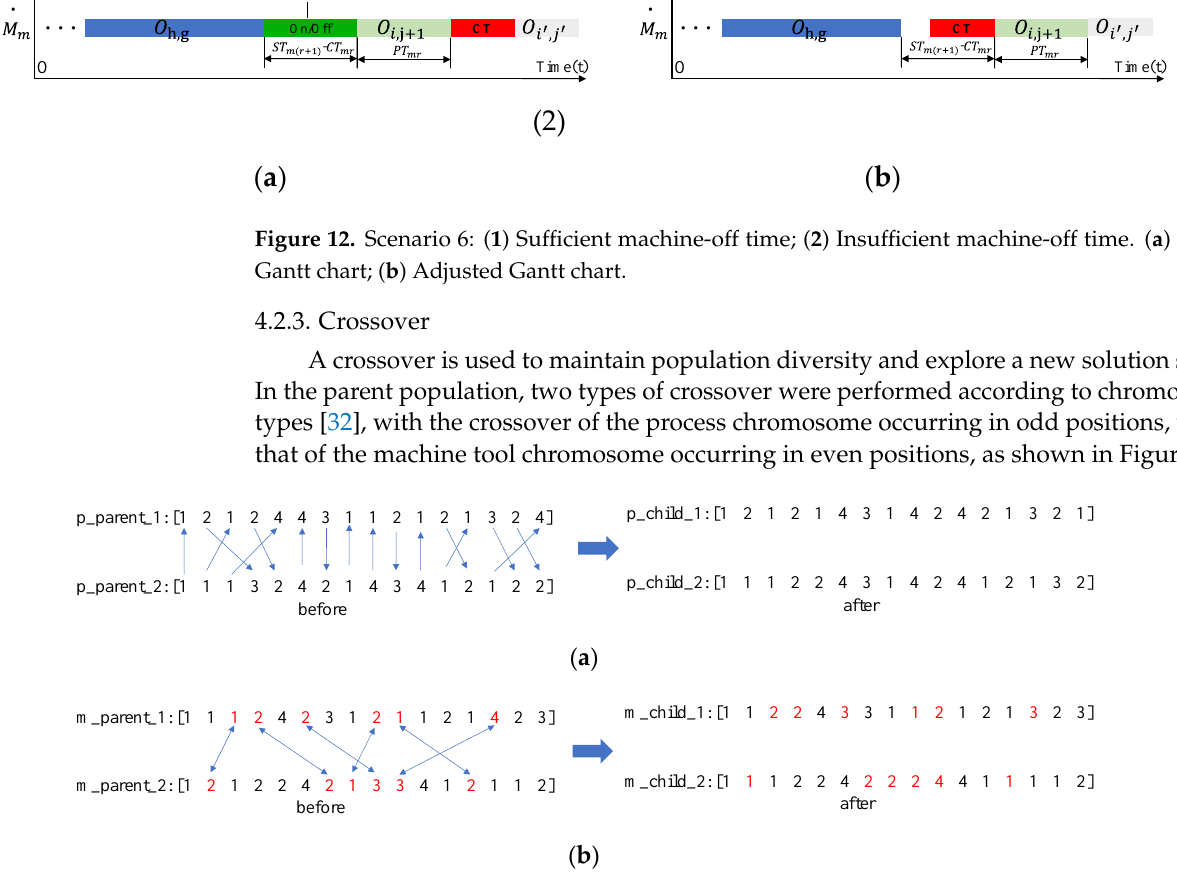
chromosome. tool